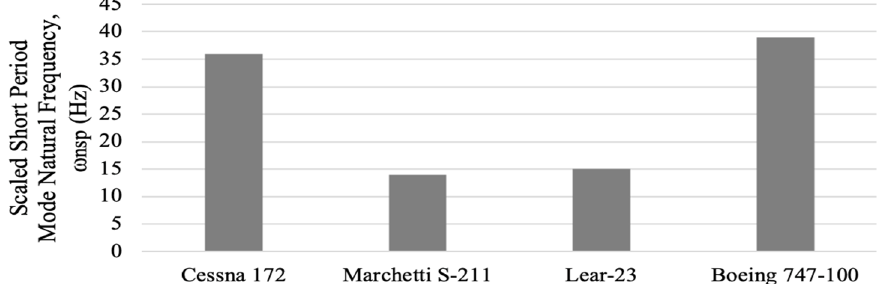
Figure 2. Short Period Modes of Aircraft Scaled to a 30 cm (1 ft) Size.